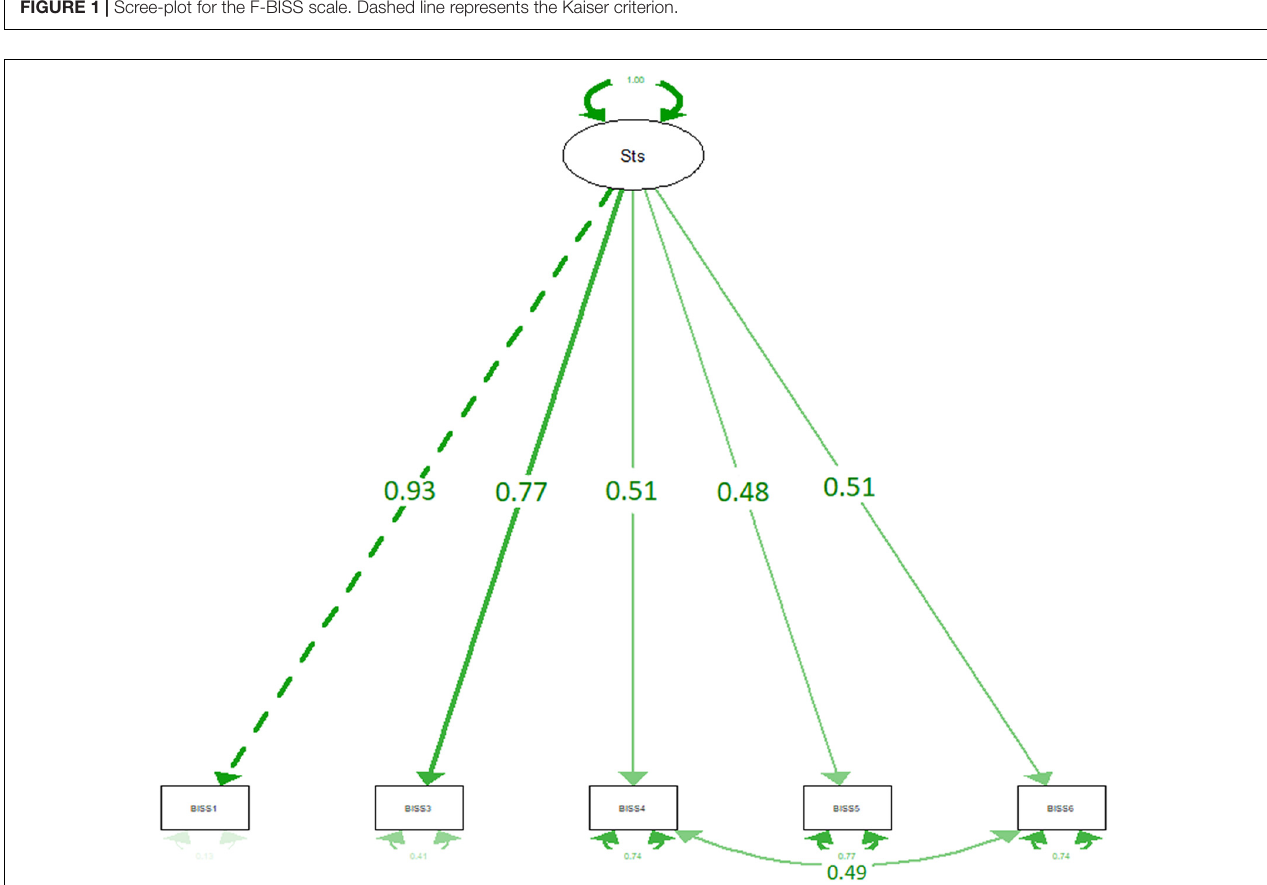
FIGURE 2 | Confirmatory factor analysis of the BISS (model 2). Sts, main factor. One-way arrows represent factor loading. Two-way arrows represent correlations between